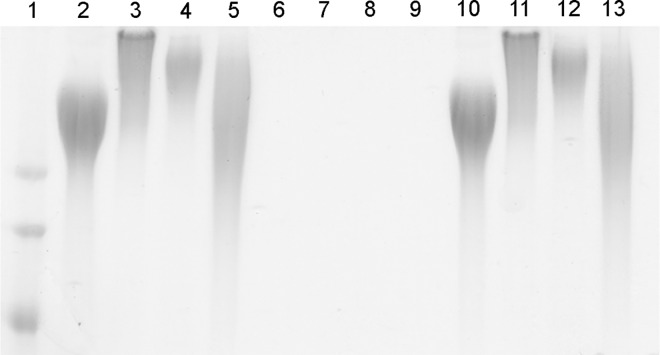
Comparison of capsule migration pattern between capsule types.Alcian blue stained gel depicting the migration pattern of capsule material purified from the surface of the source strains (lanes 2–5), capsule locus deletion mutants (lane 6–9), and the capsule complements (lanes 10–13). Lane 1, ladder; lane 2, KK01; lane 3, PYKK58; lane 4, PYKK60; lane 5, BB270; lane 6, KK01Δcsa; lane 7, PYKK58Δcsb; lane 8, PYKK60Δcsc; lane 9 BB270Δcsd; lane 10, KK01Δcsa(csa); lane 11 PYKK58Δcsb(csb); lane 12, PYKK60Δcsc(csc); lane 13 BB270Δcsd(csd).